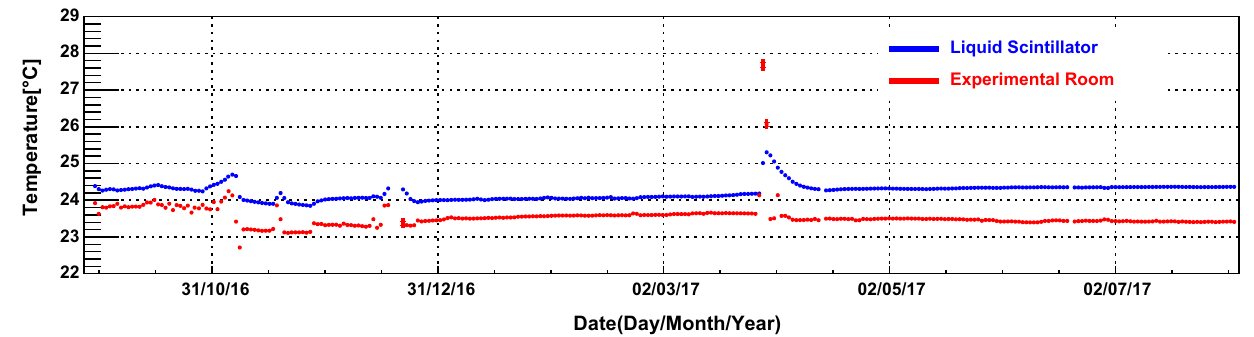
Fig. 13 Temperature measurements as a function of time in 1year period. The temperature of the liquid scintillator in the vicinity of Crystal-2 and one of the detector room temperatures are displayed.